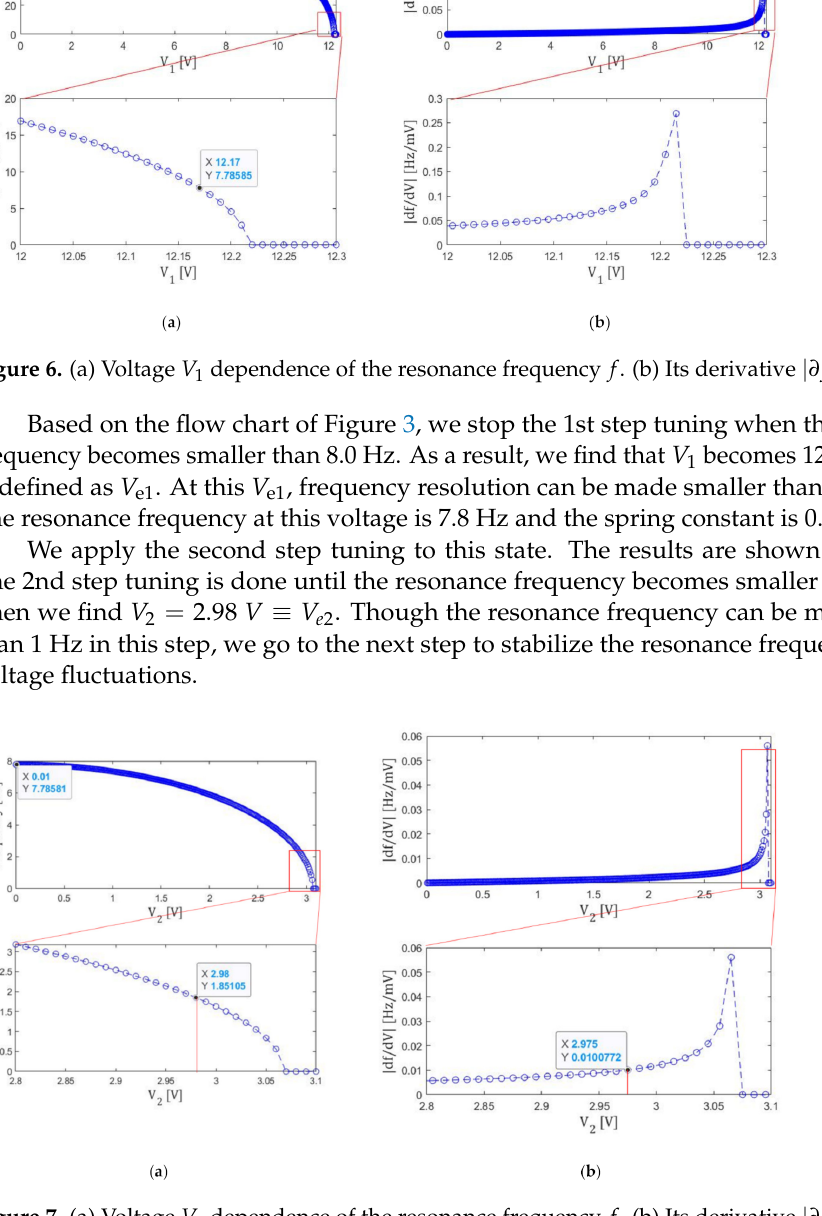
Figure 7. (a) Voltage V 2 dependence of the resonance frequency f . (b) Its derivative | ∂ f / ∂ V 2 | . At this V e2 , due to the smaller electrode area, the slope | ∂ f / ∂ V 2 | can be made smaller than 0.01 Hz/mV. The resonance frequency after this step is 1.85